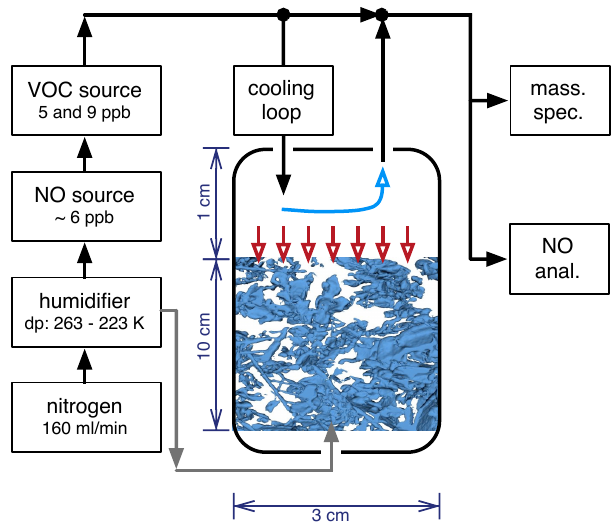
Fig. 1. Illustrative scheme of the experimental set-up showing the snow diffusion chamber. A N 2 flow containing traces of acetone, methanol, and NO is passed over a snow sample (blue arrow). The trace gases diffuse into the porous snow sample from the headspace (red arrows). Before the experiments the sample can be purged to remove volatile impurities (grey arrow). Dew point is denoted as dp, filled circles represent three-way valves, and NO is added to confirm correct preparation of the snow samples (see text for